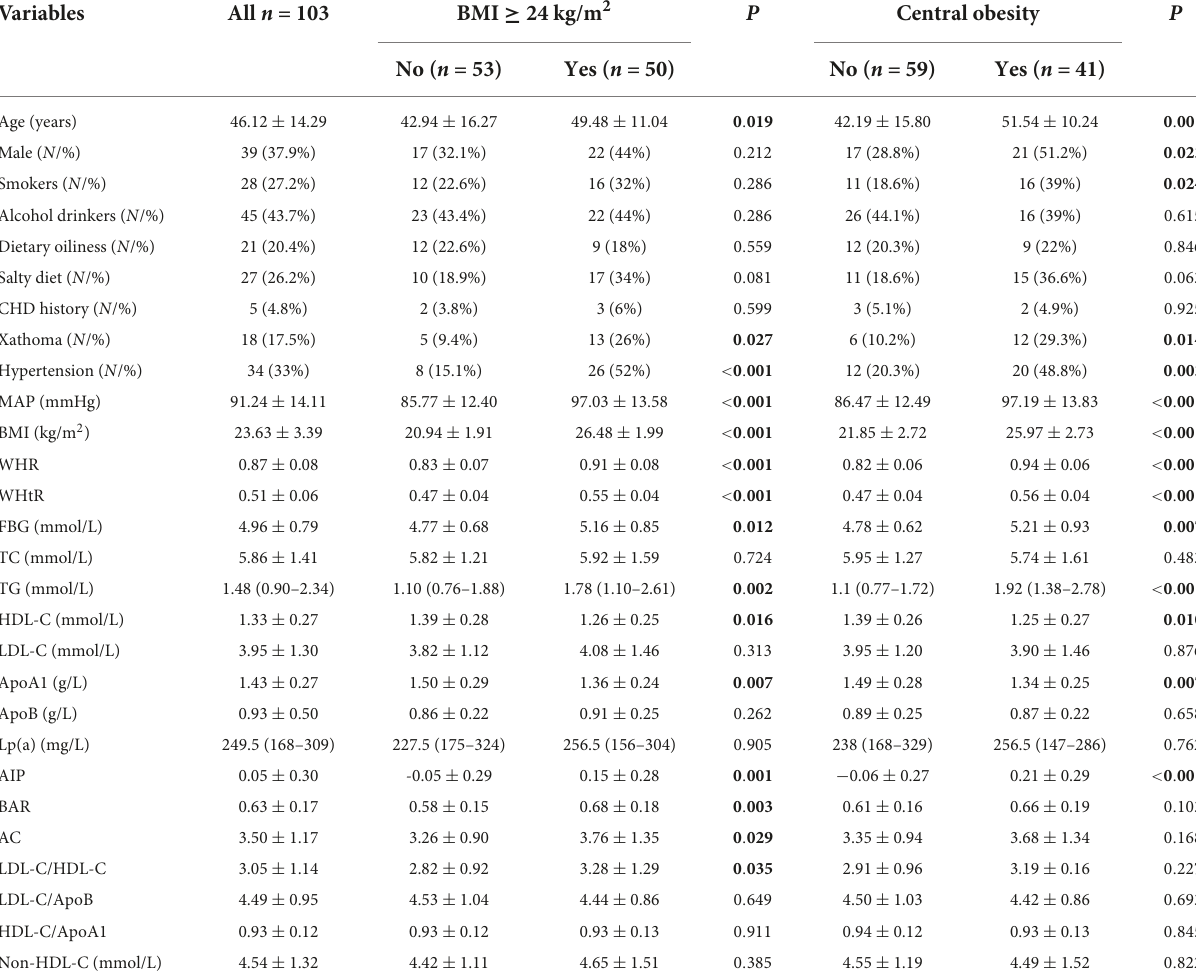
TABLE 1 Basic Clinical features of patients with familial